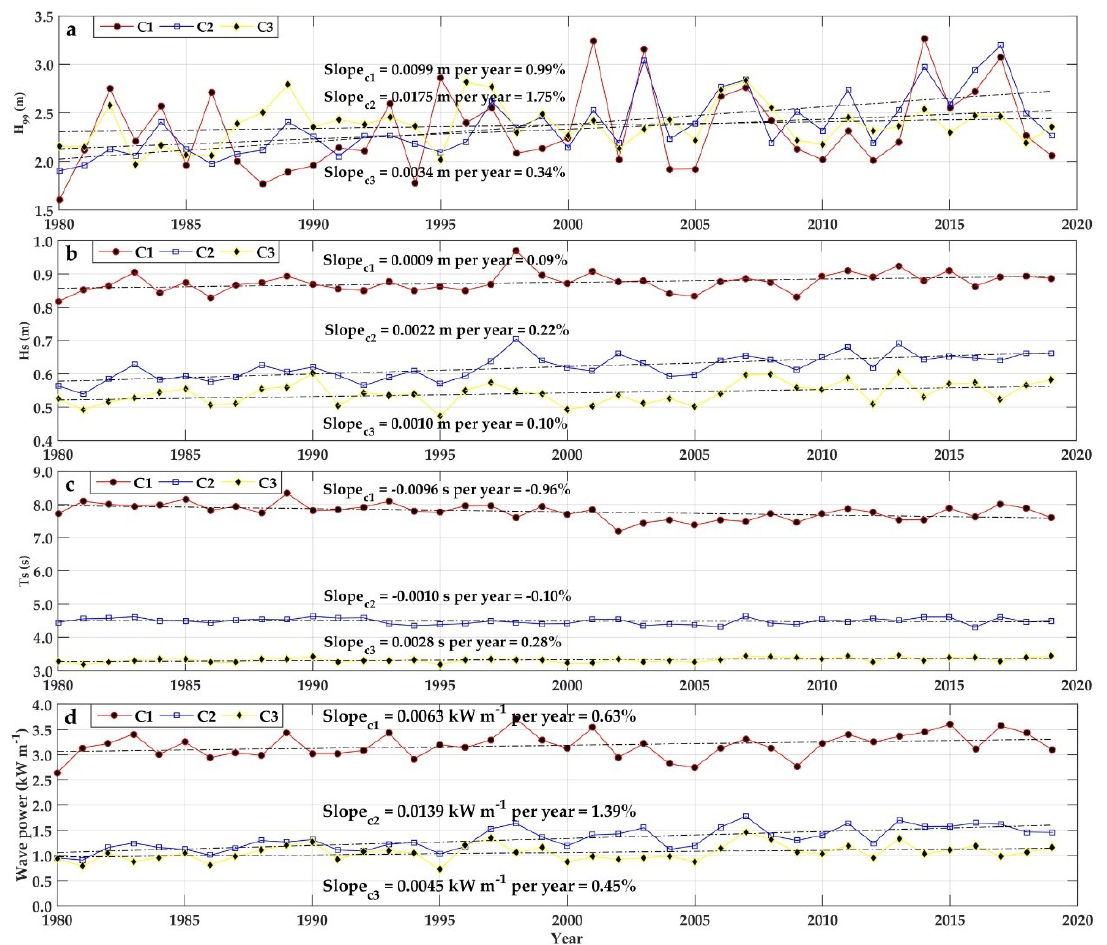
Figure 6. Variability of annual means of H 99 , H s , T s and P at C1, C2 and C3 during the 40-year period